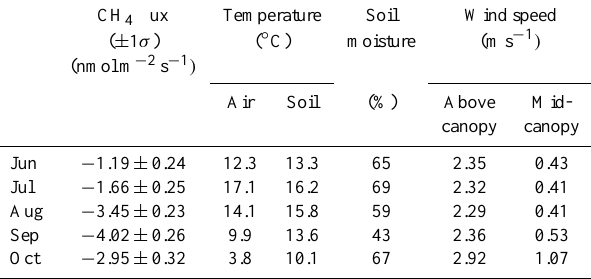
Table 1. Monthly averages of eddy covariance CH 4 fluxes and an- cillary measurements.